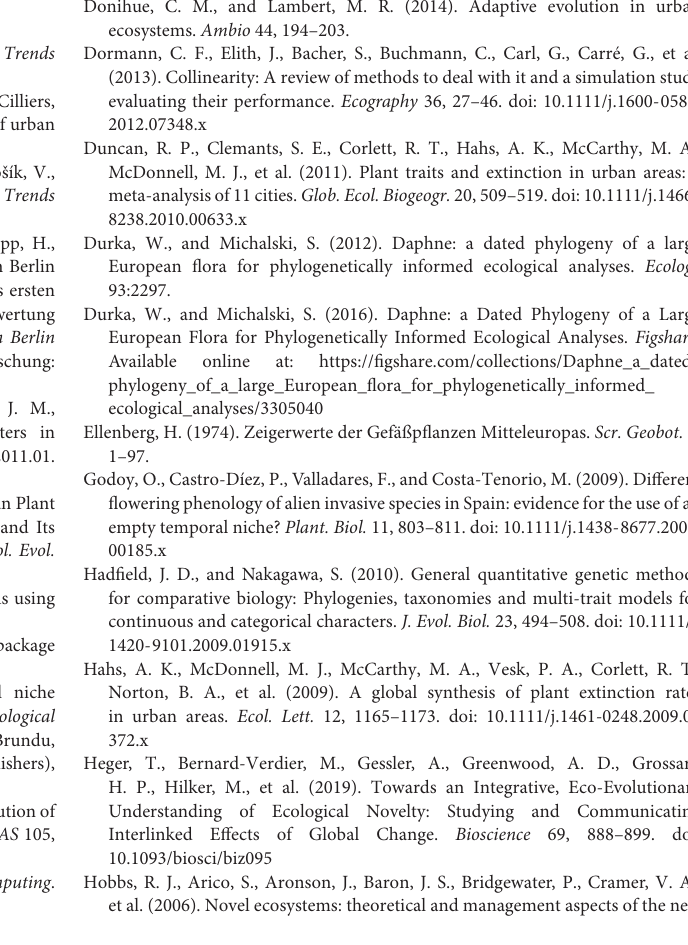
Supplementary Table 3 | List of vascular plant species occuring in Berlin, Germany with selected traits, the type of ecosystem species occur in within Berlin (natural remnant, hybrid, novel immature, and novel mature ecosystems), species native status (whether species are native or non-native to Berlin — the latter distinguishing among archaeophytes and neophytes), and whether species have established or casual occurrence in the four types of ecosystems (0 = casual occurrence, 1 = established occurrence). This list is underlying the full model described in this